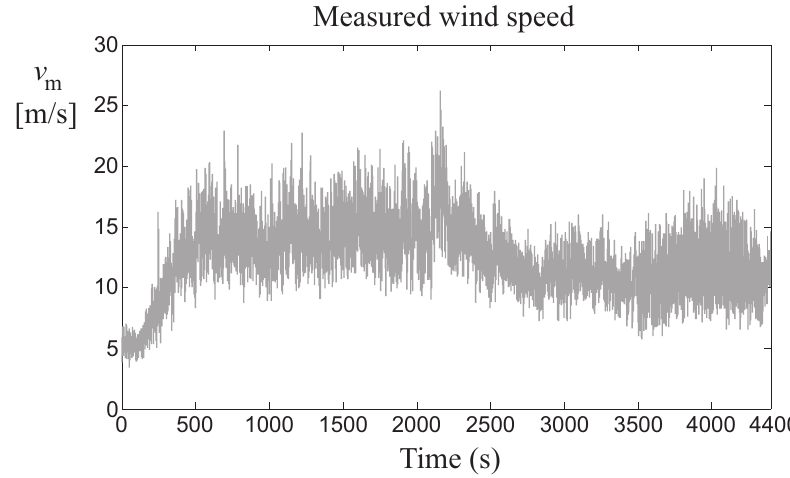
Figure 8. Measured wind speed signal example driving the WT